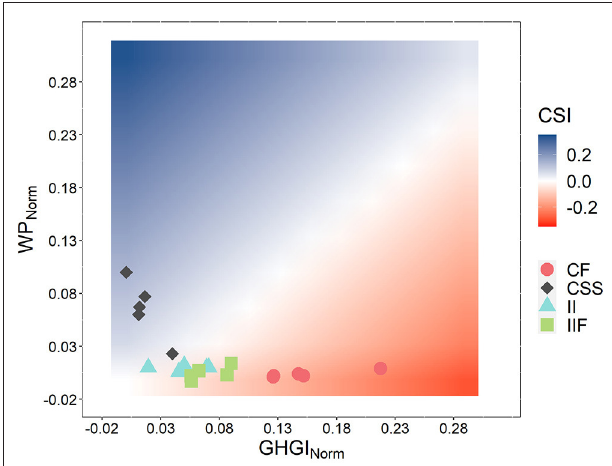
FIGURE 6 | Heatmap of Climate-smartness Index (CSI) scores of the Continuous flooding (CF), Intermittent irrigation until Flowering (IIF), intermittent irrigation (II) and Continuous soil saturation (CSS)